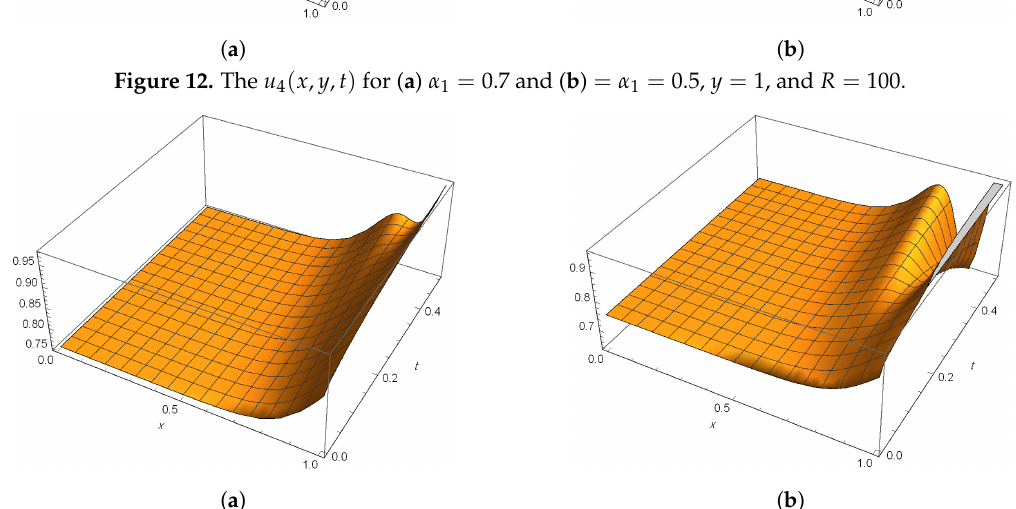
Figure 13. The v 4 ( x , y , t ) for ( a ) α 2 = 0.7 and ( b ) = α 1 = 0.5, y = 1, and R =